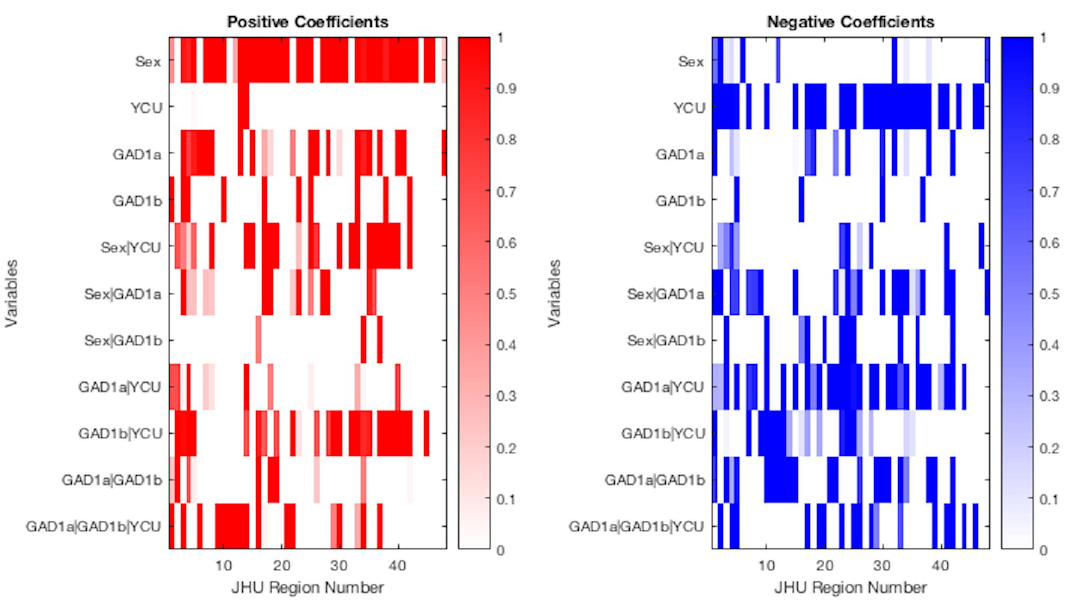
Fig 3. Proportion of positive coefficients (left) for significant voxels by variables across JHU Atlas regions, and negative (right). The color key represents the extent of FA alteration. White color indicates the absence of significant voxels for the specific combination of brain regions by JHU Atlas among genetic variants, Sex, and